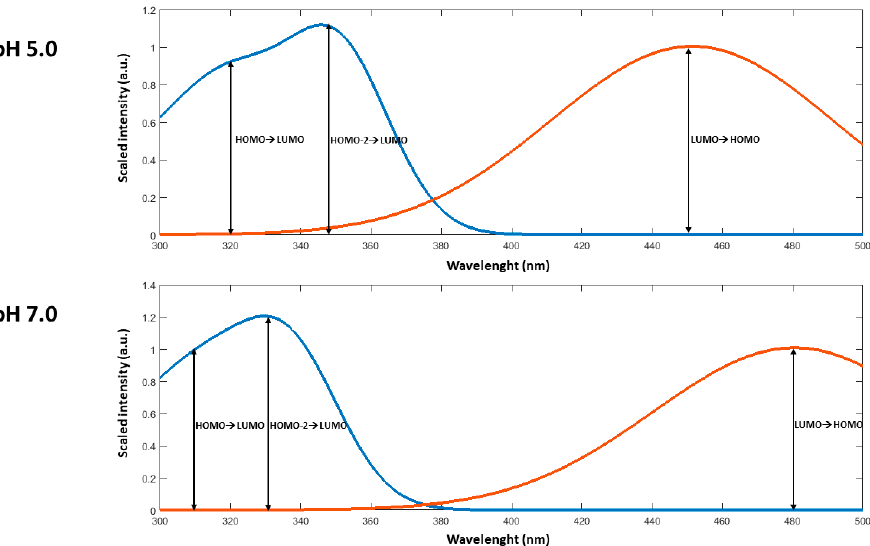
Figure 8. Predicted absorption (blue line) and emission (red line) spectra for C1 at pH 5.0 and pH 7.0.